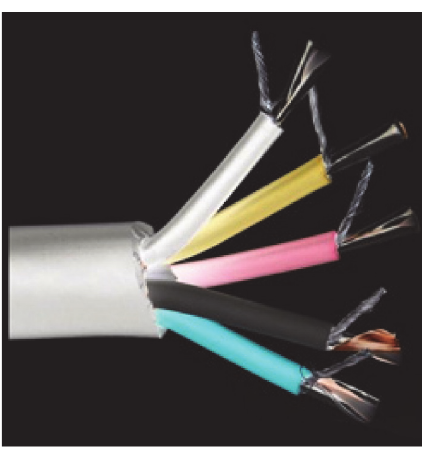
Figure 11: Centroid positioning. Table 1: Statistical table of the accuracy of image recognition of mobile phone core